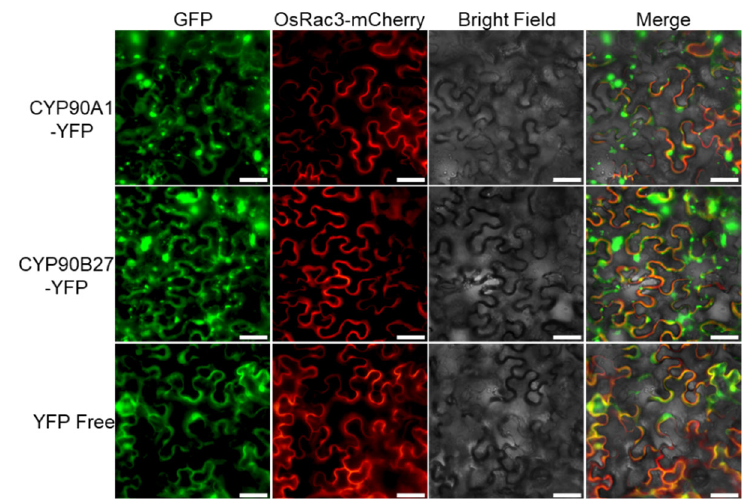
Figure 5. Subcellular localization of CYP90A1 and CYP90B27 in N. benthamiana leaves. Transiently expressing p35S::CYP90A1-YFP or p35S::CYP90B27-YFP fusion protein in the leaves of N. benthamiana by A. tumefaciens . Transient expression of p35S::YFP was used as the control. Subcellular localizations of the fused proteins were analyzed by fluorescence microscopy at 48 h after infiltration. The OsRac3 ‐ mCherry fusion protein is a plasma membrane marker. Scale bars = 50 μ m.